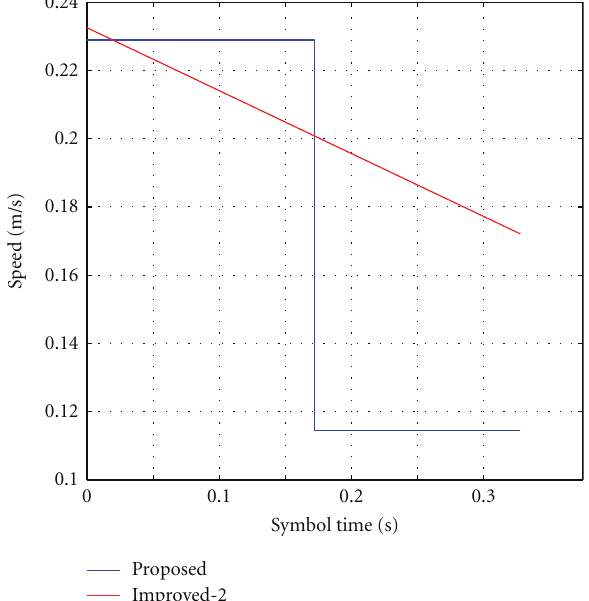
Figure 13: Improved time-varying speed estimation during OFDM symbol 7 of packet